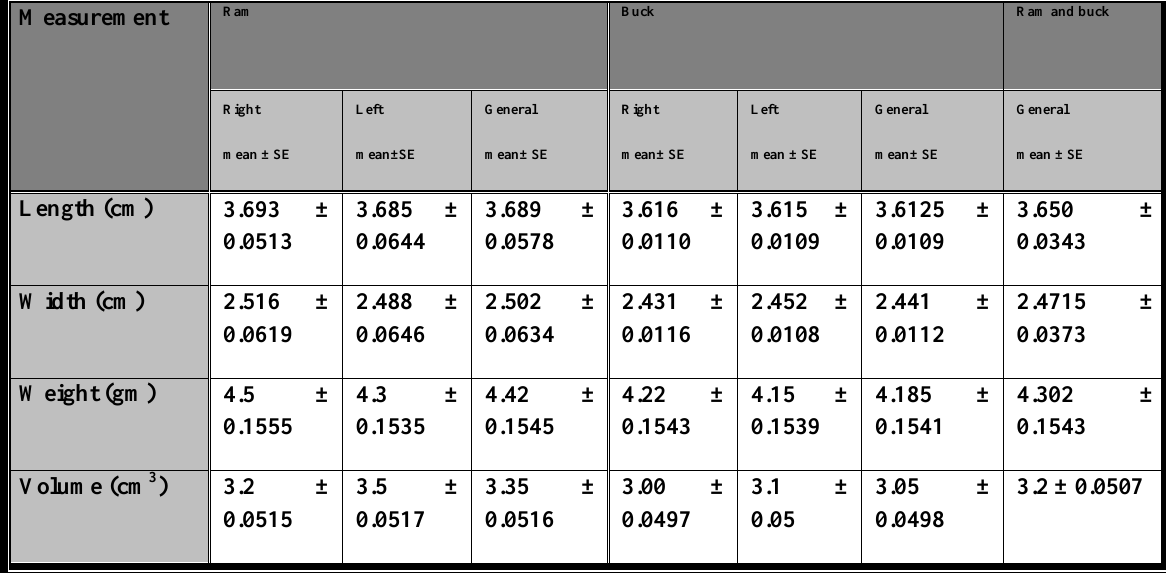
Table 2: Anatomical parameter of seminal vesicle gland in ram and buck. Measurement